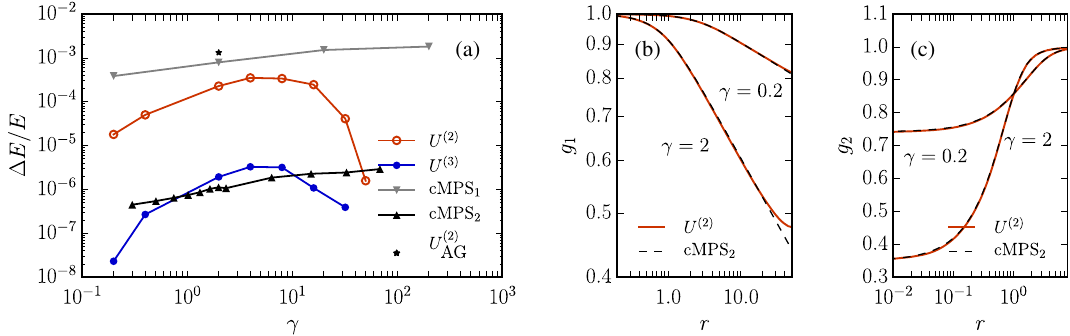
FIG. 1. Ground-state properties of the Lieb-Liniger model as obtained from different variational approaches: (a) relative accuracy of the ground-state energy, (b) one-body density matrix, (c) density-density pair correlation functions. U ð 2 Þ and U ð 3 Þ denote results for the 2 Þ two- and three-body expansion (present work), U ð is the parametrized two-body Jastrow state of Ref. [52], cMPS 1 results are from AG Ref. [23], and cMPS 2 are those very recently reported in Ref. [24]. Distances r are in units of the inverse density 1 =n . Our variational results are obtained for N ¼ 100 particles. Finite-size corrections on local quantities are negligible, and very mildly affect the reported large-distance correlations. Overall statistical errors are of the order of symbol sizes for (a) and line widths for (b) and